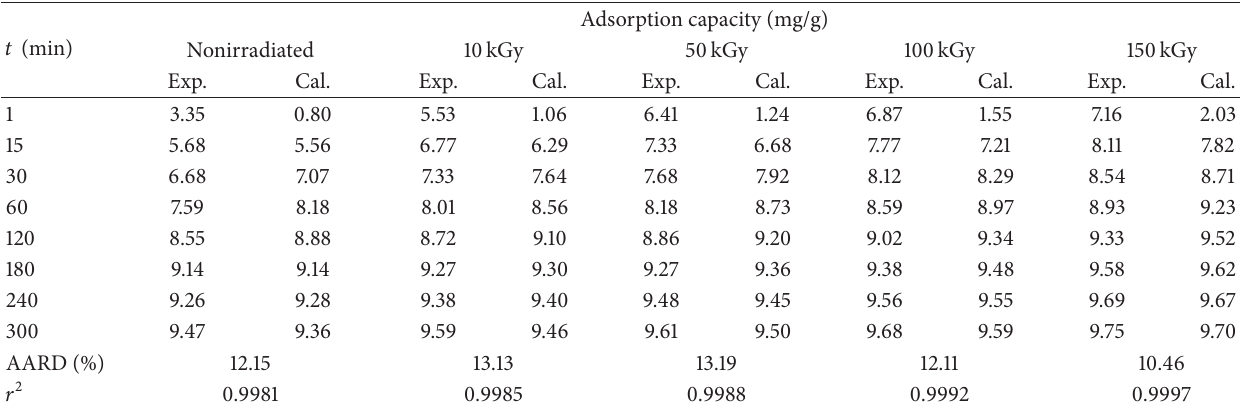
Table 4: Experimental and calculated lead adsorption capacity of nonirradiated and irradiated minerals ( 𝐶 0 = 100 mg/L, 𝑇 = 20 ∘ C, 𝑤 = 1 g, and 𝑉 = 0.1 L).